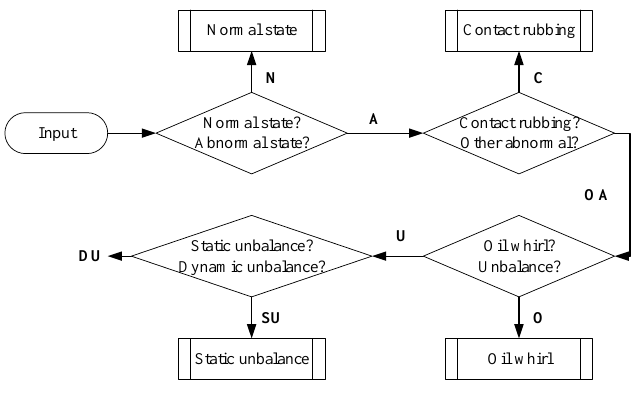
Figure 4. Stepwise diagnosis process.